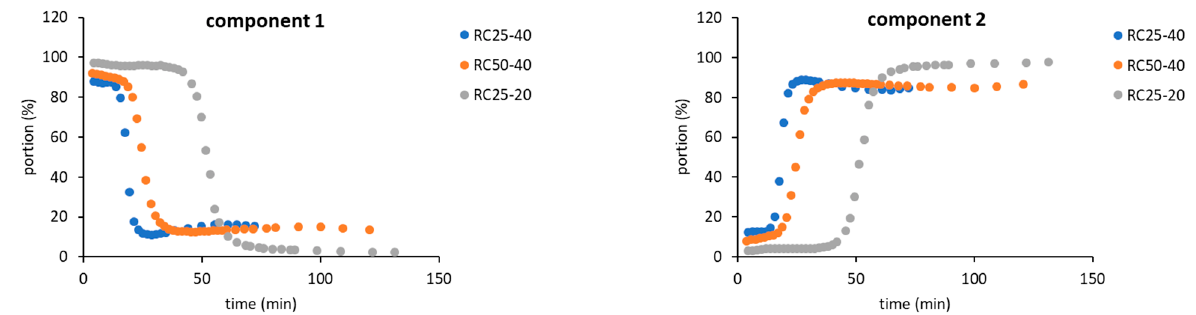
Figure 4. Relaxation times of two expected components during RF condensation.